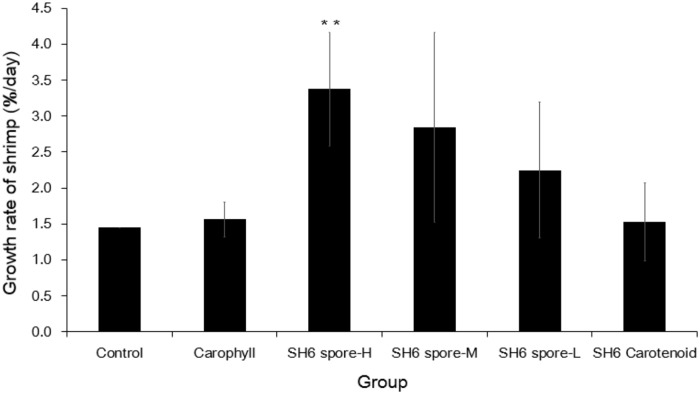
Growth rate of L. vannamei after 28 d feeding with SH6 spores.Experiment includes negative control, Carophyll (astaxanthin: 0.5 mg/g pellet), SH6 carotenoid (SH6 carotenoids: 5 μg/g pellet), and SH6 spore-H/M/L groups (SH6 spores at 5 × 106, 1 × 106, 2 × 105 CFU/g pellet, respectively). Growth rate factor is indicated by weight gain (%) per day. Data are presented as arithmetic means and error bars are standard deviations (n = 20). P values were generated using Student’s t-test for multiple comparisons to the control. P values were generated using Student’s t-test for comparison to the control (**P <0.01).